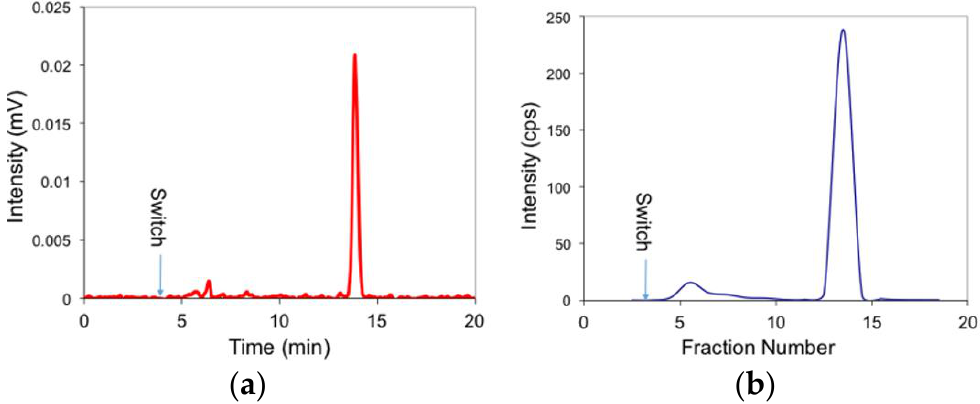
Figure 2. Comparison of high performance liquid chromatography (HPLC) chromatogram and plasma fractions counted in a gamma counter for a [ 18 F] flurpiridaz sample. ( a ) Raw chromatogram from inline coincidence detector (60% CH 3 CN in phosphate buffered saline eluted through a C-18 column (Waters Xbridge BEH, 130Å; 100 × 4.6 mm, 3.5 µ m) at 1 mL/min; ( b ) 2 mL fractions from the HPLC analysis were counted on the gamma counter, then plotted as smoothed line for comparison.